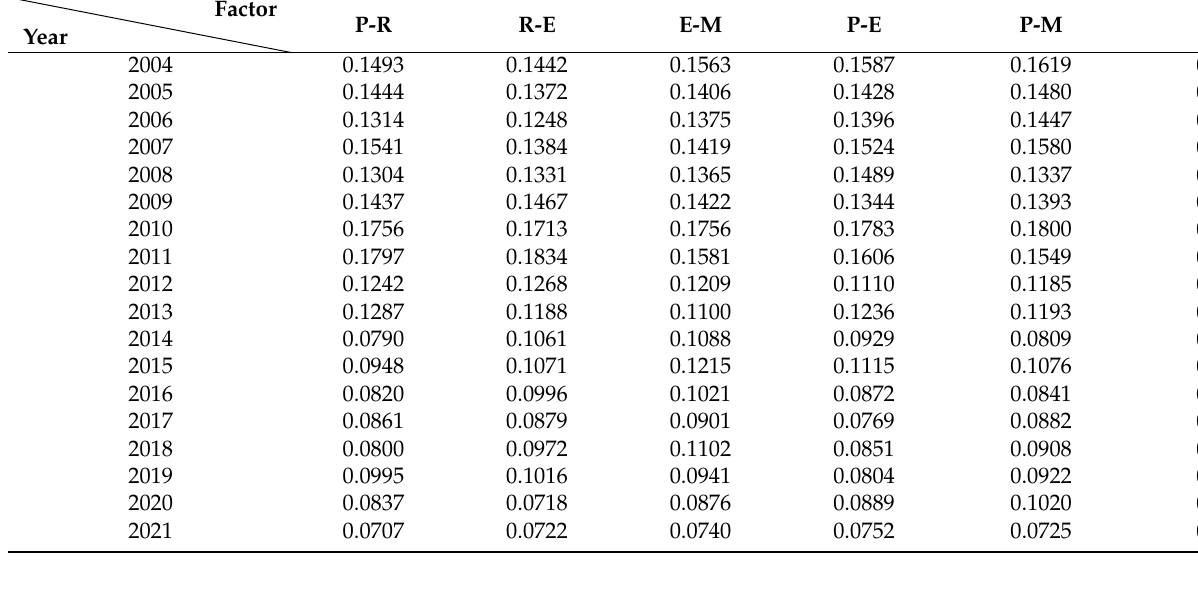
Figure 5. Visualization of coupling degree calculation results. Table 6. The comprehensive coordination index